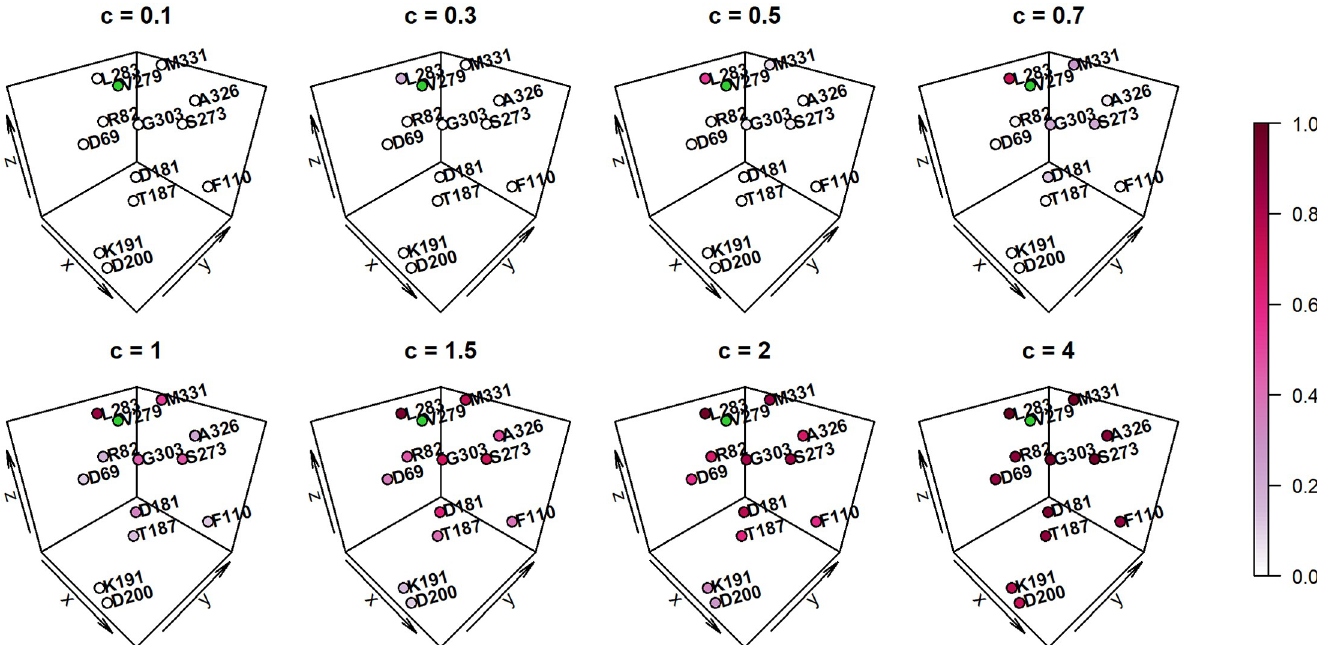
Fig 3. Information-borrowing map for PLA2G7 variant V279. Information-borrowing map shows the amount of borrowing from neighboring variants for PLA2G7 variant V279 for different values of c , with darker color representing higher levels of contribution via the variant correlation matrix R .